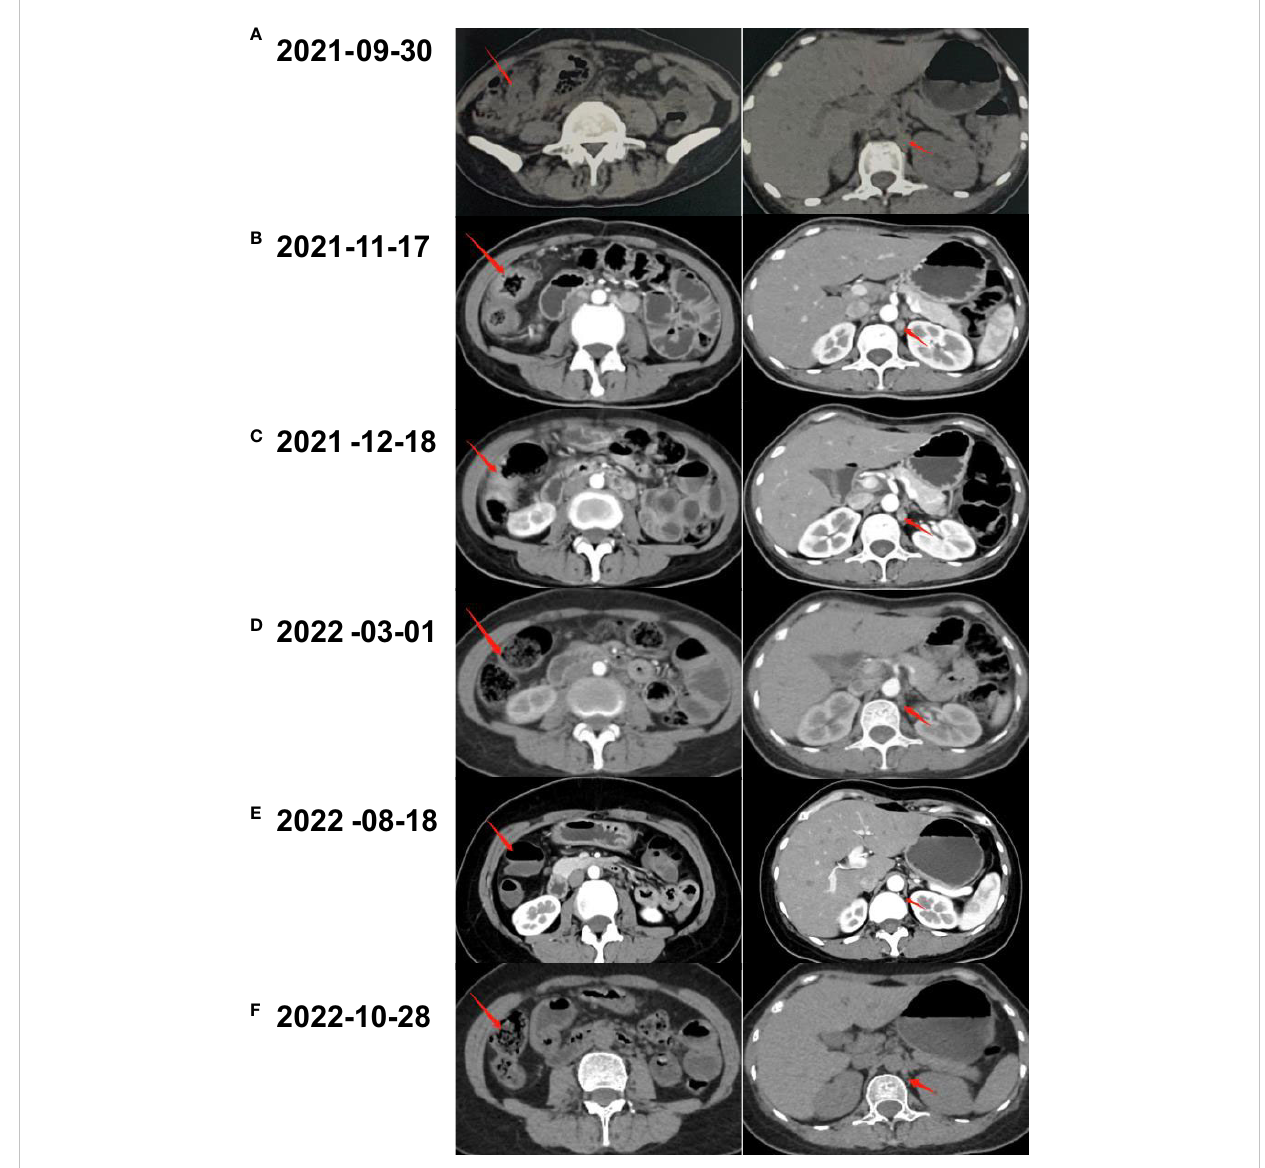
FIGURE 2 Abdominal CT scanning of the patient. (A) A neoplasm located in the right colon and thickened nodule in the retroperitoneal were shown by CT before treatment. (B) After three cycles of the combination of mFOLFOX6 and bevacizumab, CT demonstrated shrunken tumors in abdomen. (C) The lesion of colon and nodular did not continue to regress after another two cycles of chemotherapy plus targeted therapy. (D) CT scan revealed that the lesions came to gradual diminishment after eight cycles of envafolimab. (E) Thirty-six cycles of envafolimab later, the lesion in the right colon completely disappeared. (F) The patient kept clinical complete response with the use of envafolimab 400mg every 3